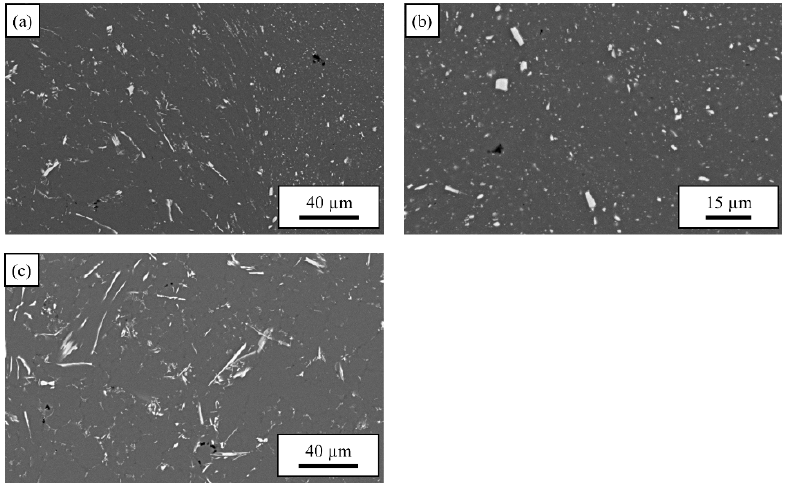
Figure 7. Detail of cross-section of AlMg4Fe2 at 500 mm/min: ( a ) thermomechanically affected zone (TMAZ); ( b ) weld nugget (WN); and ( c ) base material.